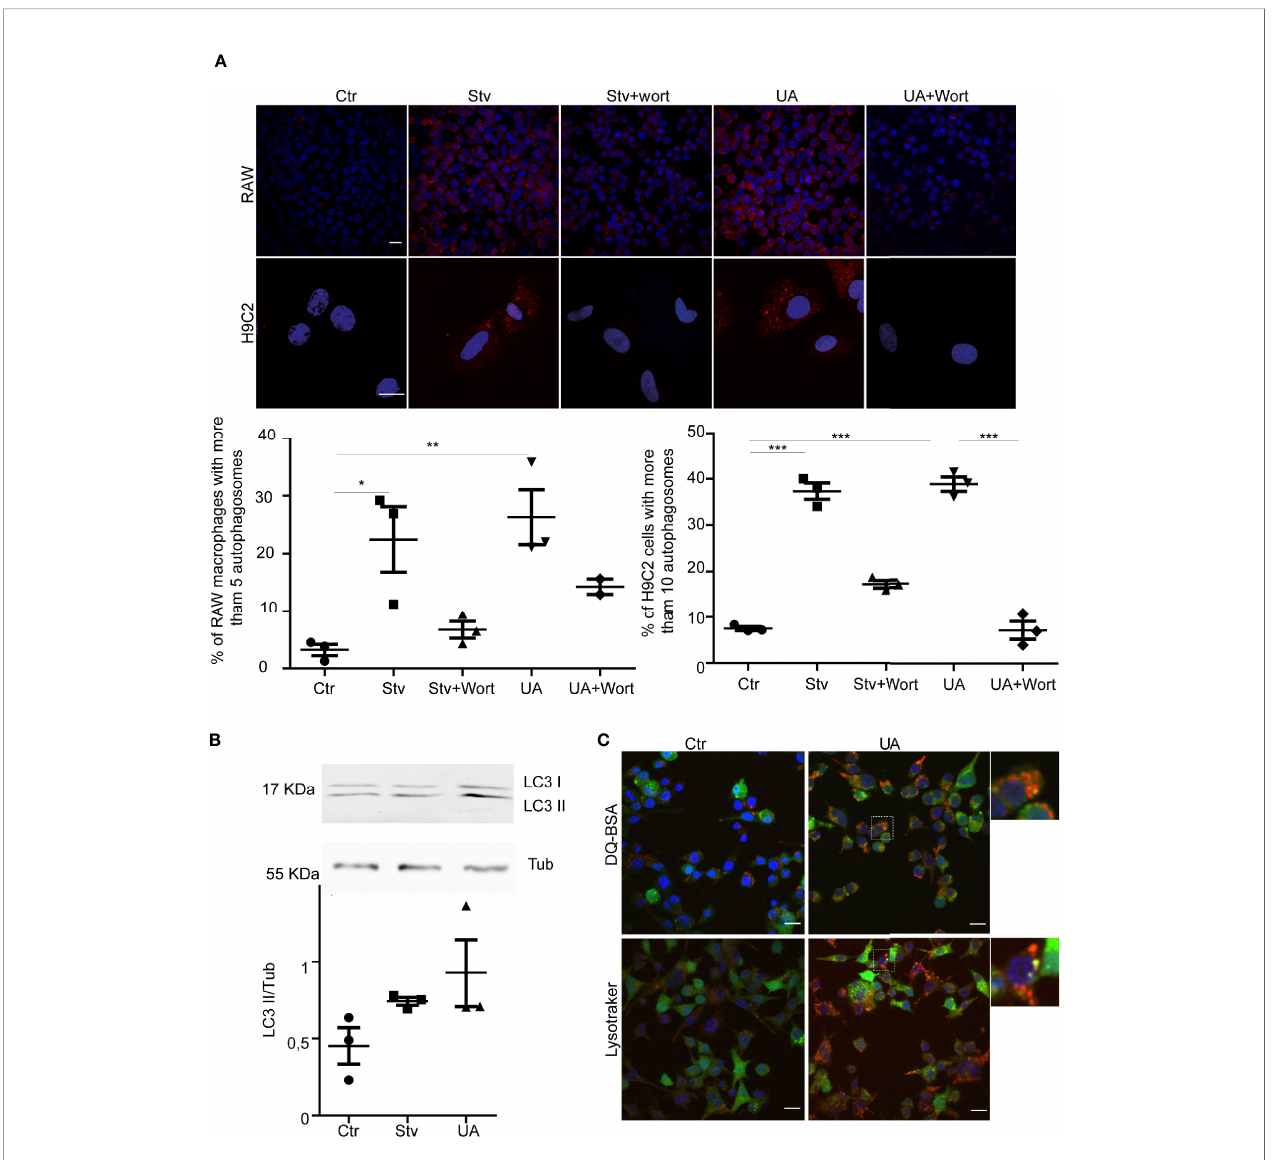
FIGURE 2 | Ursolic acid (UA) stimulates autophagy in RAW macrophages and H9C2 Cells. RAW macrophages or H9C2 cells were incubated for 2 h in control or starvation medium (Stv) or in control medium supplemented with 10 µM of UA alone (UA) or in the presence of 100 nM of wortmannin (UA+Wort) or starvation medium (Stv) in the presence of 100 nM of wortmannin (Stv+Wort) as indicated in Methods . (A) Images show the LC3 (red) distribution in the indicated conditions. Scale bars, 10 m m. Graph represents the percentage of cells with more than 5 dots (RAW macrophages) or 10 dots per cell (H9C2 cells) in each condition. Data represent the mean ± SEM of three independent experiments (number of counted cells in each experiment ≈ 100). *p < 0.05, **p < 0.01. Tukey ’ s test. (B) Top panel: representative immunoblot of three experiments corresponding to LC3 detection is depicted. Bottom panel: quanti fi cation of the LC3II/Tub ratio. Data are representative of three independent experiments. (C) RAW macrophages overexpressing GFP-LC3 were grown in control medium in the presence or absence of 10 µM of UA (UA) for 2 h. Confocal images depict GFP-LC3 and DQ-BSA or LysoTracker distribution under the indicated conditions. Scale bars, 10 m